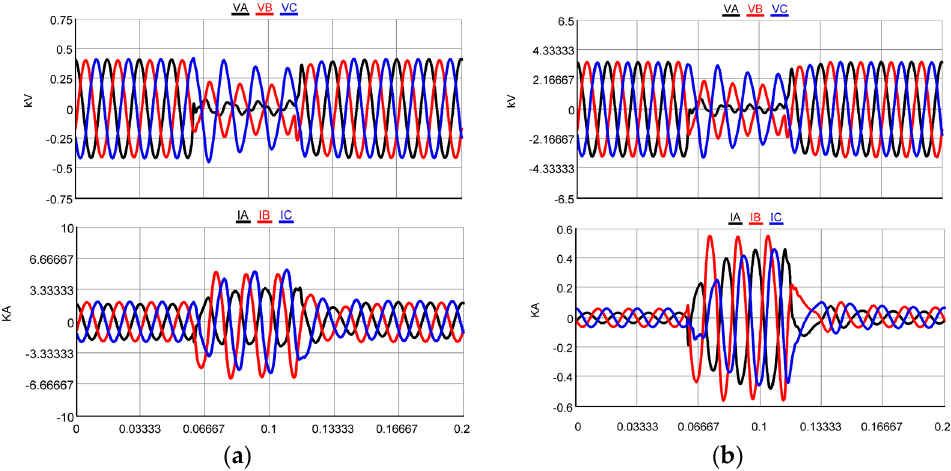
Figure 11. Double line-to-ground fault applied at bus 6 in the transmission system of the testbed: ( a ) instantaneous voltage and current at bus 634; ( b ) instantaneous voltage and current at bus 680.